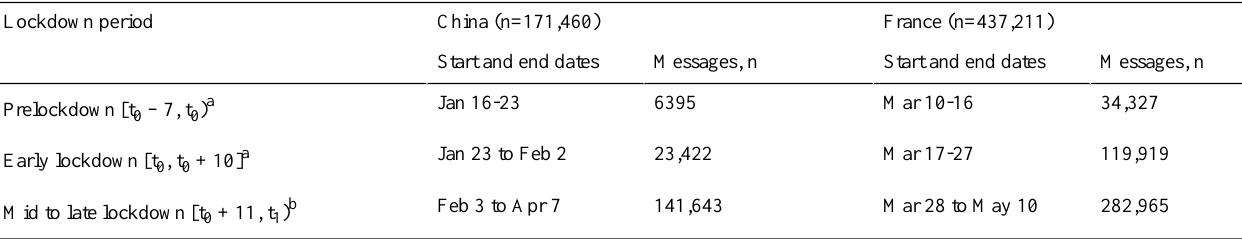
Table 1. Extraction